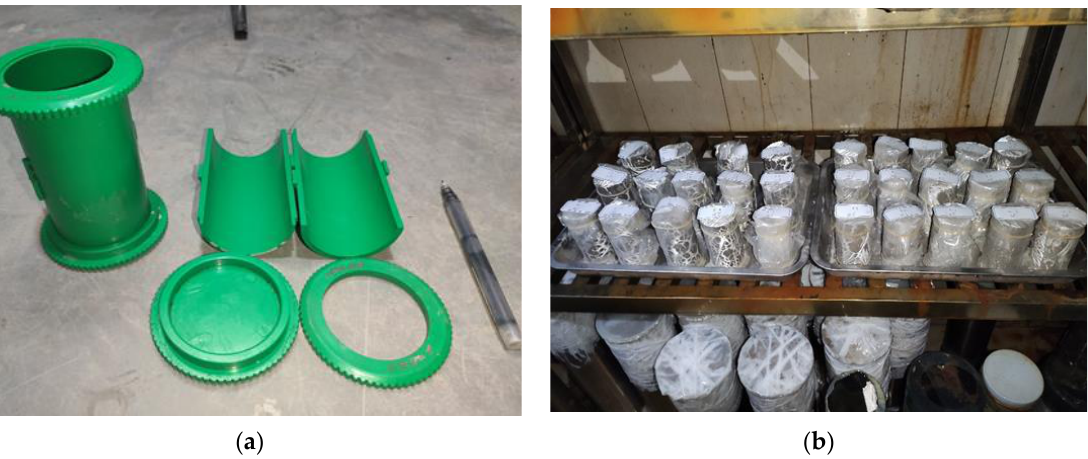
Figure 5. Preparation of specimens for unconfined compression tests. ( a ) Cylindrical moulds ( b ) Specimens in the curing room.